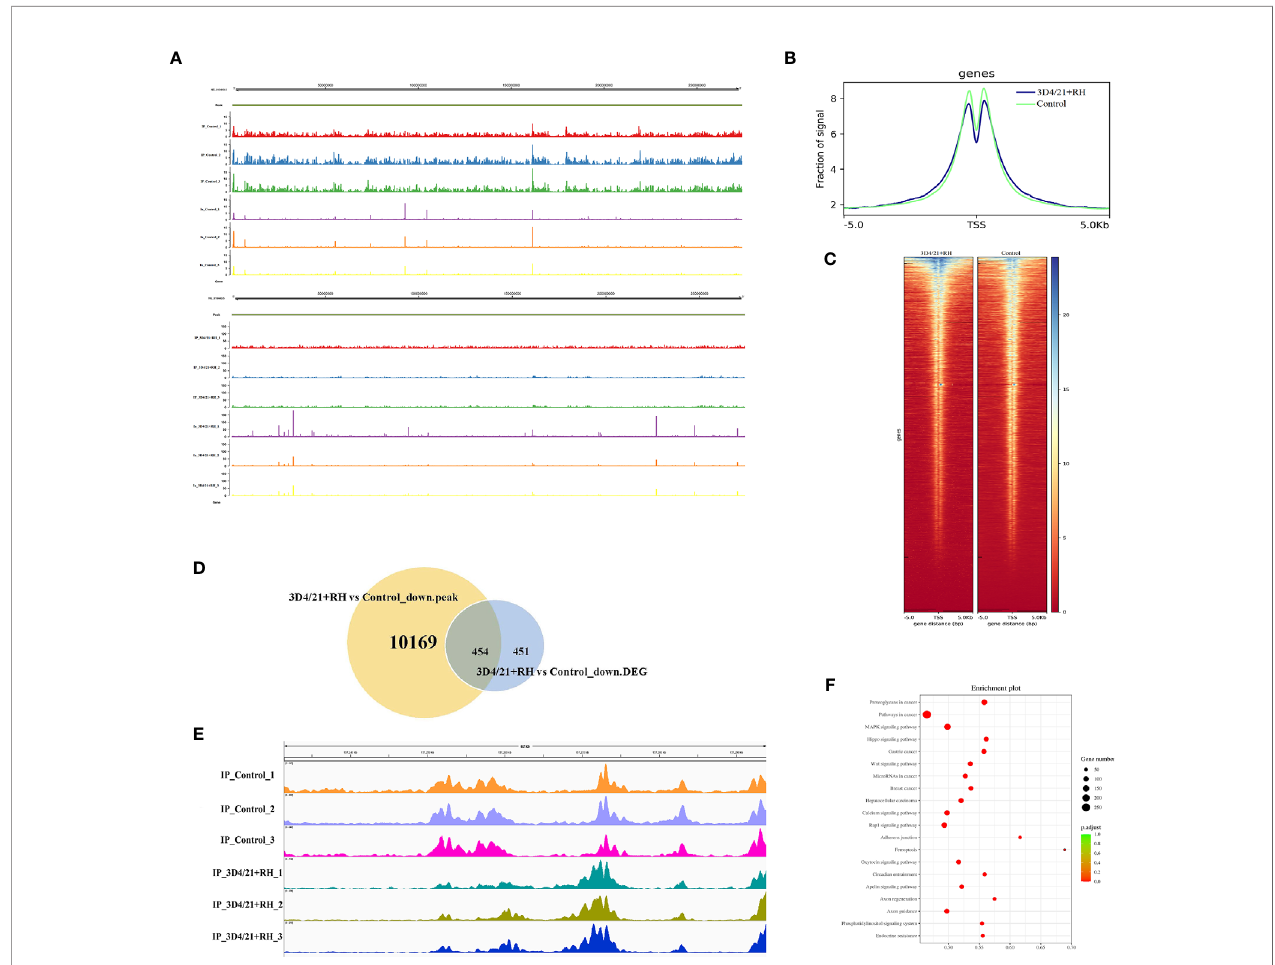
FIGURE 4 | T. gondii leads to a decrease in H2BK12cr in porcine alveolar macrophages. (A) Browser view of a segment from chromosome NC_010443.5 showing a representative pro fi le of the distribution of H2BK12cr peaks in 3D4/21+RH and control cells, respectively. (B) Average ChIP coverage levels of H2BK12cr in 3D4/ 21+RH and control cells at transcription sites. (C) ChIP-seq density heatmaps in 3D4/21+RH and control cells for H2BK12cr at TSS ± 5,000 bp. (D) Venn diagram showing the correlation analysis of downregulated peaks in ChIP-seq and downregulated DEGs in RNA-seq. (E) IGV enrichment tracks of H2BK12cr at USP4 in 3D4/21+RH and control cells, respectively. (F) Bubble diagram showing the KEGG pathways enriched by the top 20 genes with downregulated